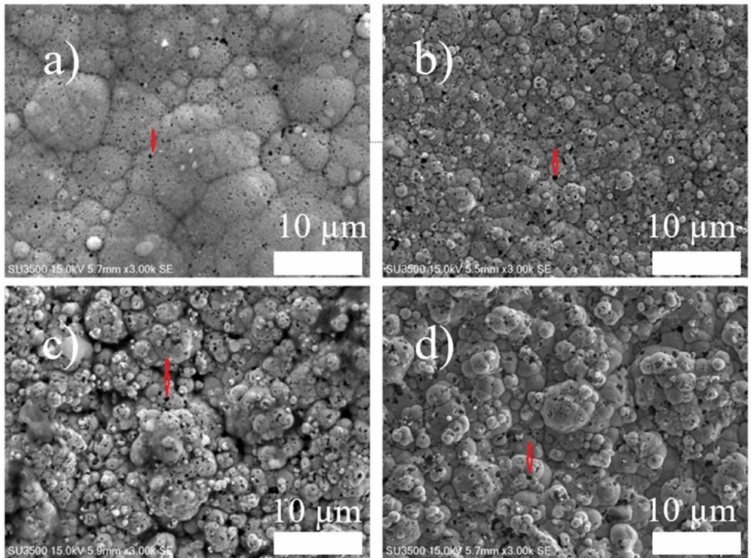
Figure 2. Scanning electron microscopy (SEM) images of Ni–W/B coatings prepared at a boron concentration of 10 g/L, peak current density of 0.20 A/cm 2 , frequency of 100 Hz and different duty cycles: ( a ) 30%, ( b ) 50%, ( c ) 70%, and ( d ) direct current (DC).